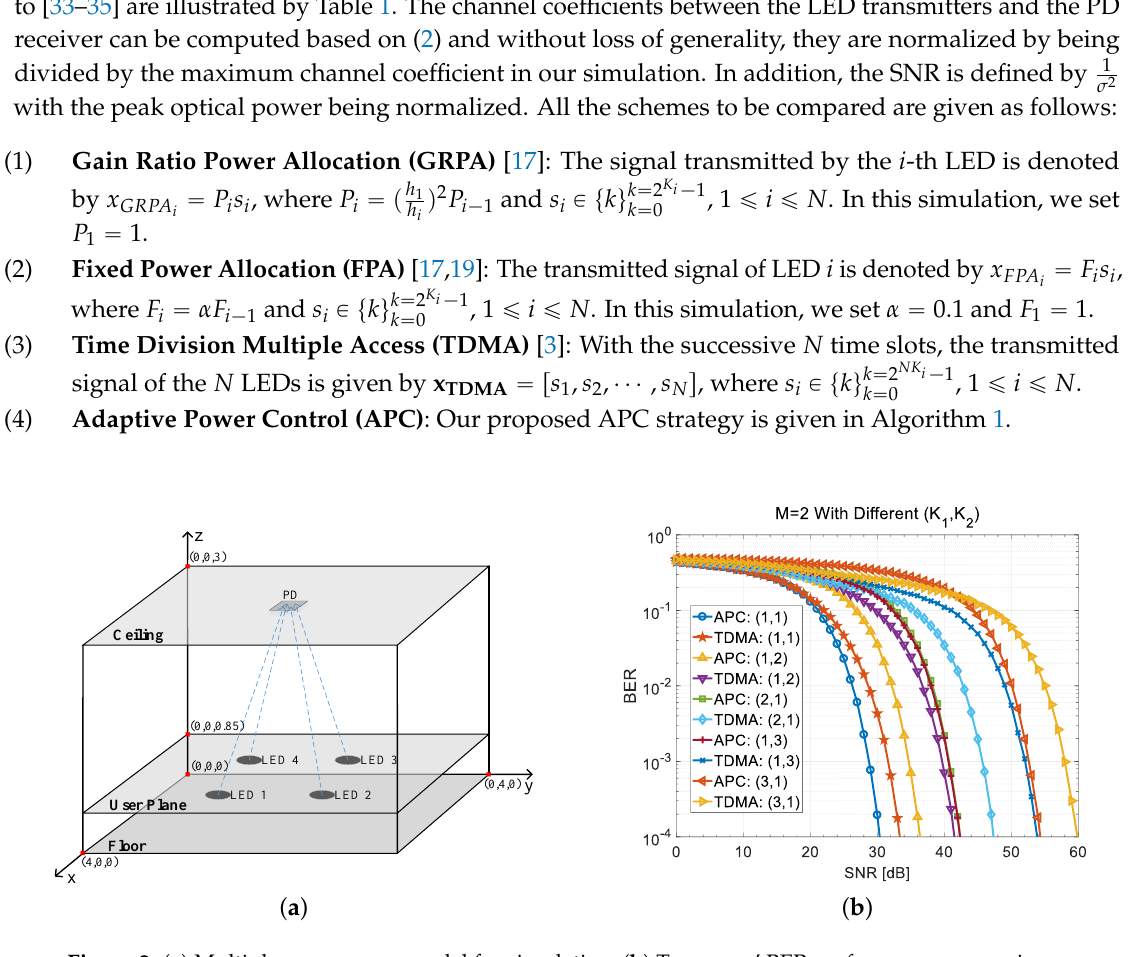
Figure 2. ( a ) Multiple access room model for simulation; ( b ) Two users’ BER performance comparisons of our proposed adaptive power control (APC) and time division multiple access (TDMA) for different p K 1 , K 2 q . Table 1. Key System